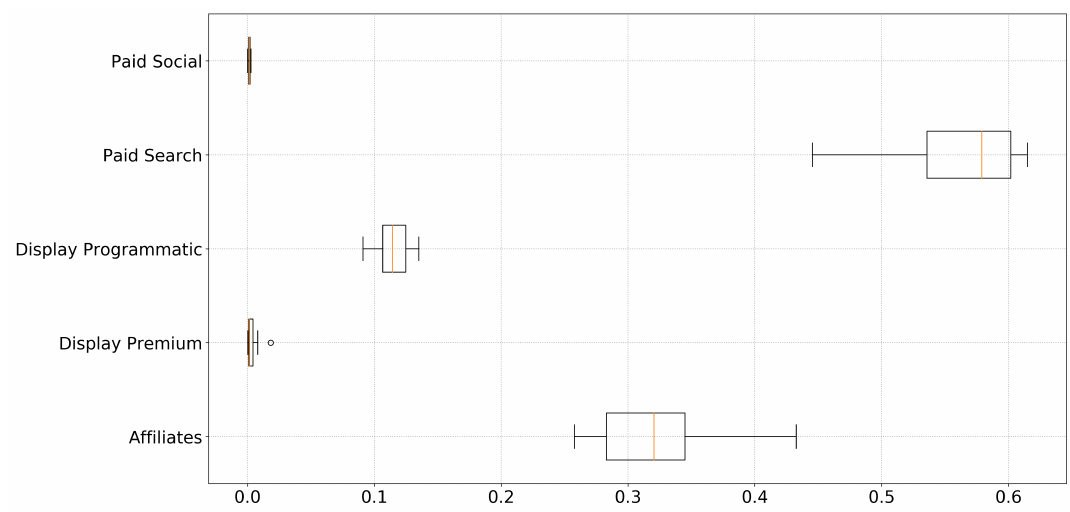
Figure 8. Proportion of the conversion value attributed to each of the channels for our ideal